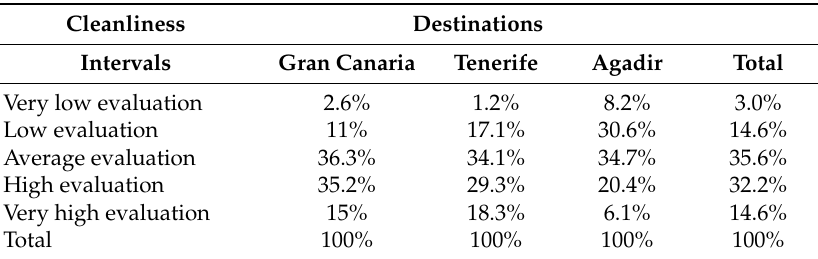
Table 2. Comparative analysis of the cleanliness